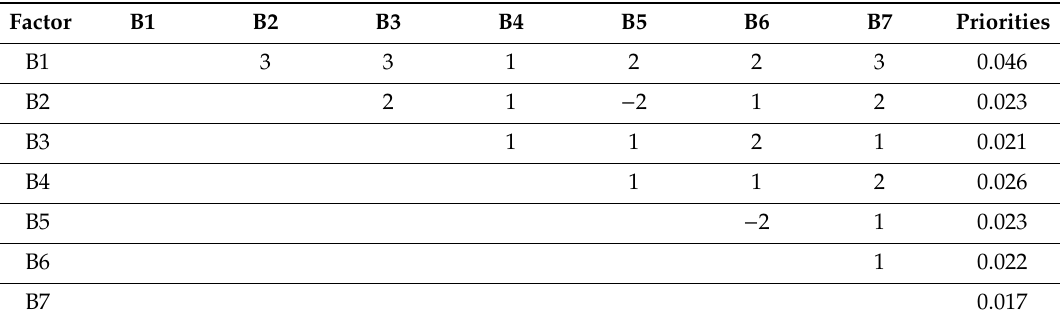
Table 6. Compare the relative importance with respect to economic and political criterion (B).